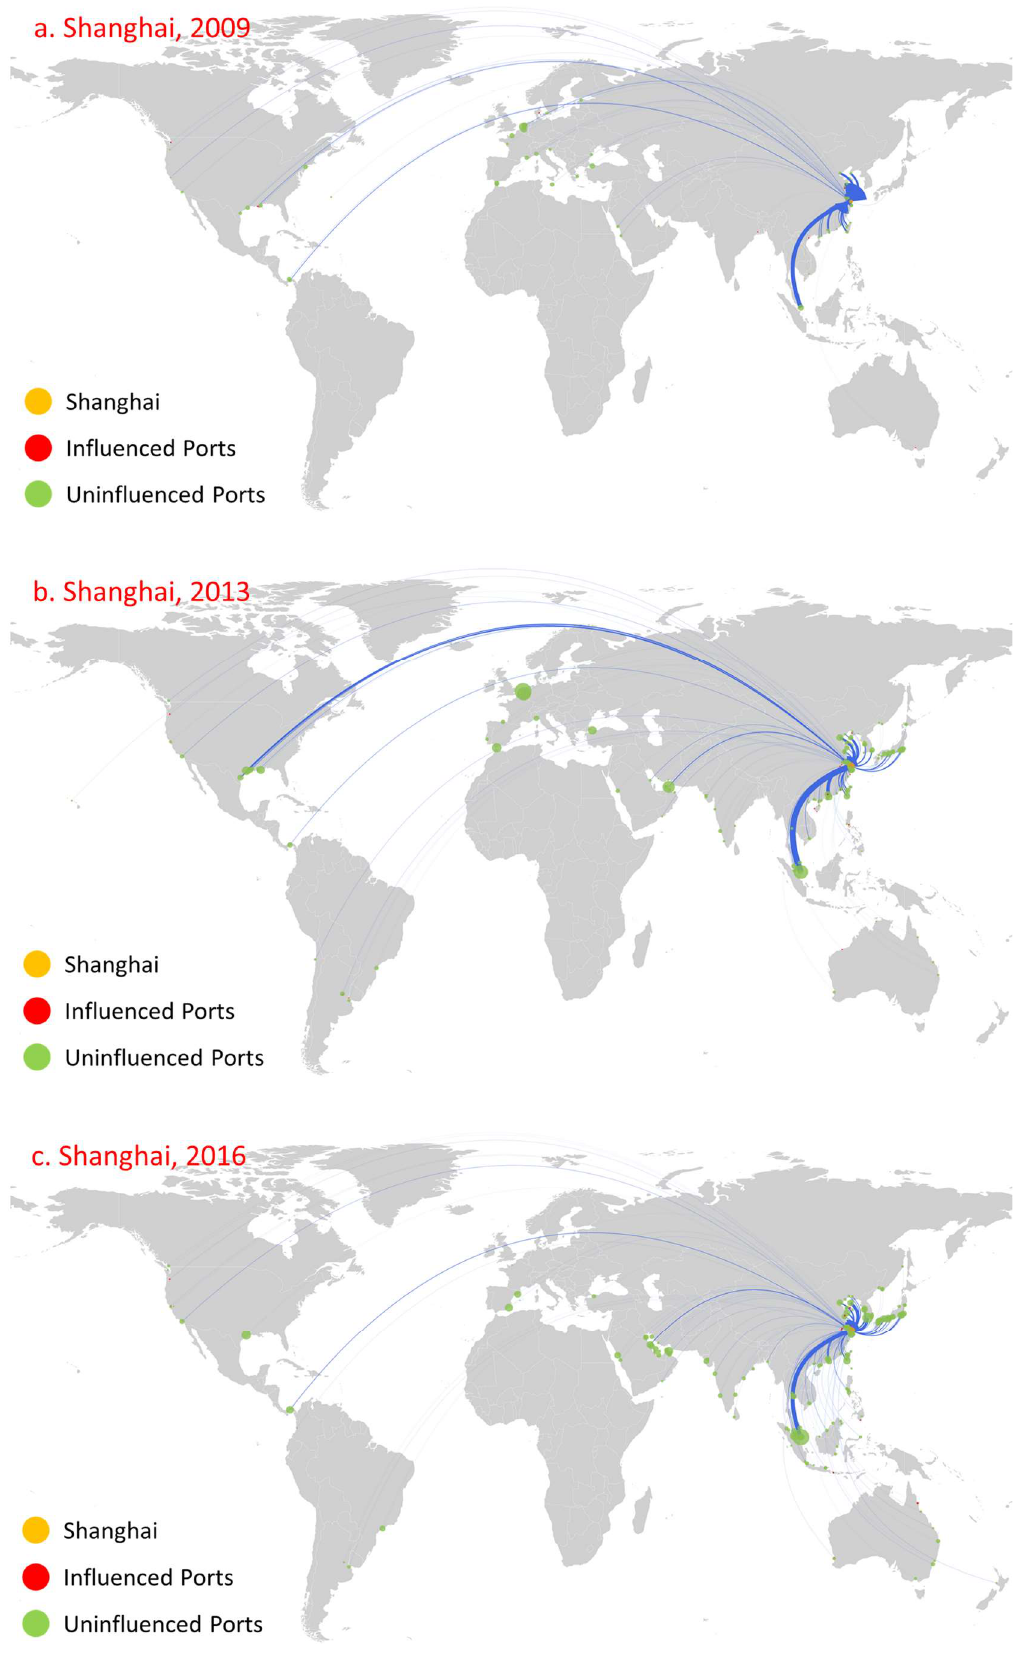
Figure 10. Influence diffusion at the first stage: Shanghai.